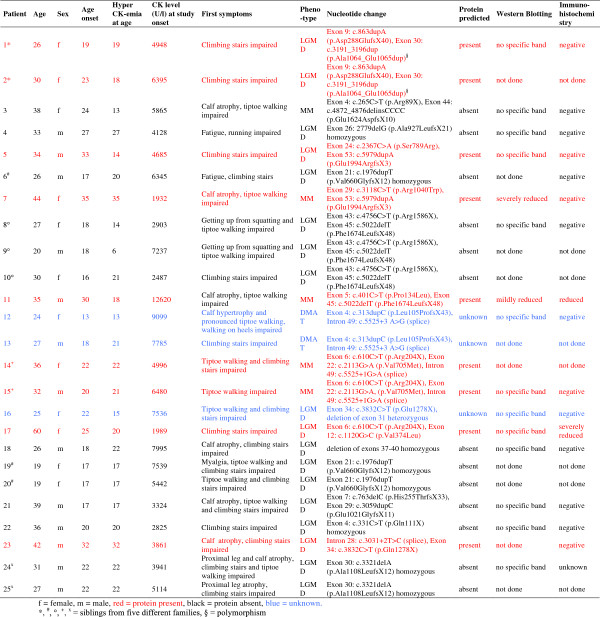
Description of the study population.